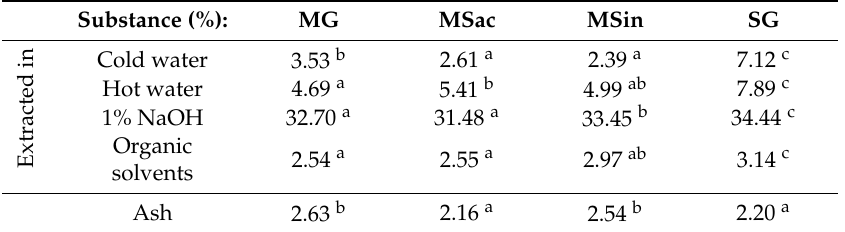
Table 3. Contents of extractives and ash in miscanthus and switchgrass lignocellulosic raw materials. Significant di ff erences among materials are marked by letter indexes, separately for each